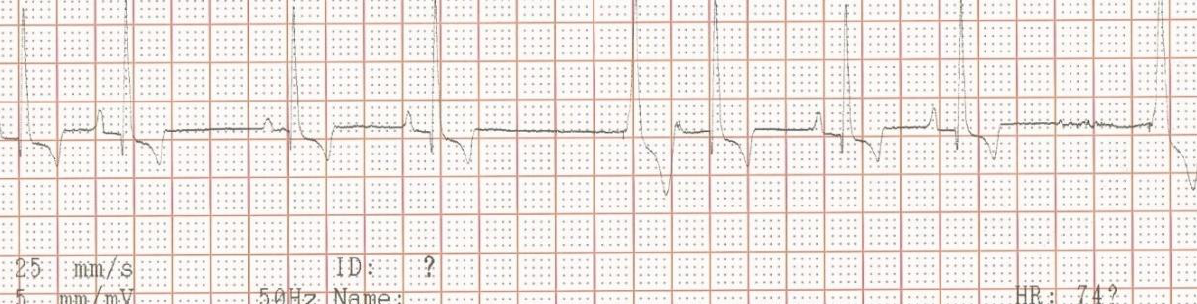
chamber (VVIR) pacing mode.